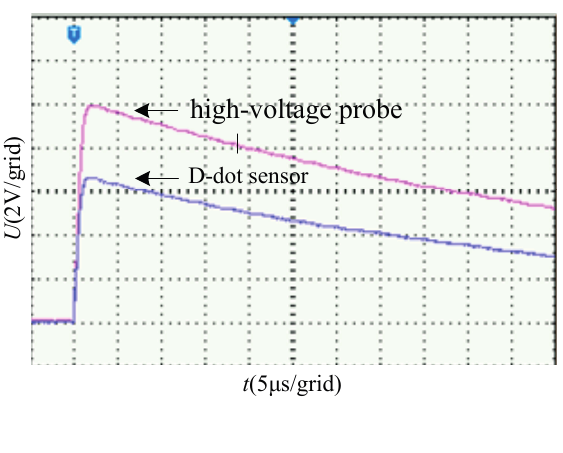
Figure 13. Transient oscillogram of 1.2/50 μ s lightning wave.